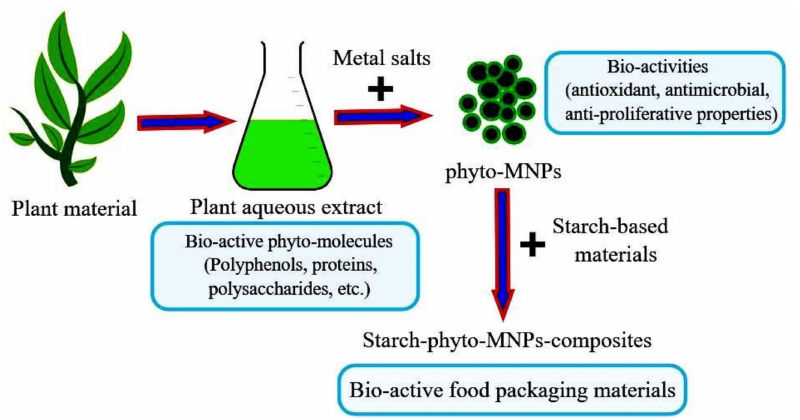
Figure 6. Schematic representation of “green” bottom-up approach to develop bioactive starch food packaging materials based on phytosynthesized metallic nanoparticles (phyto-MNPs). Figure was created with Chemix (https://chemix.org/, accessed on 15 November